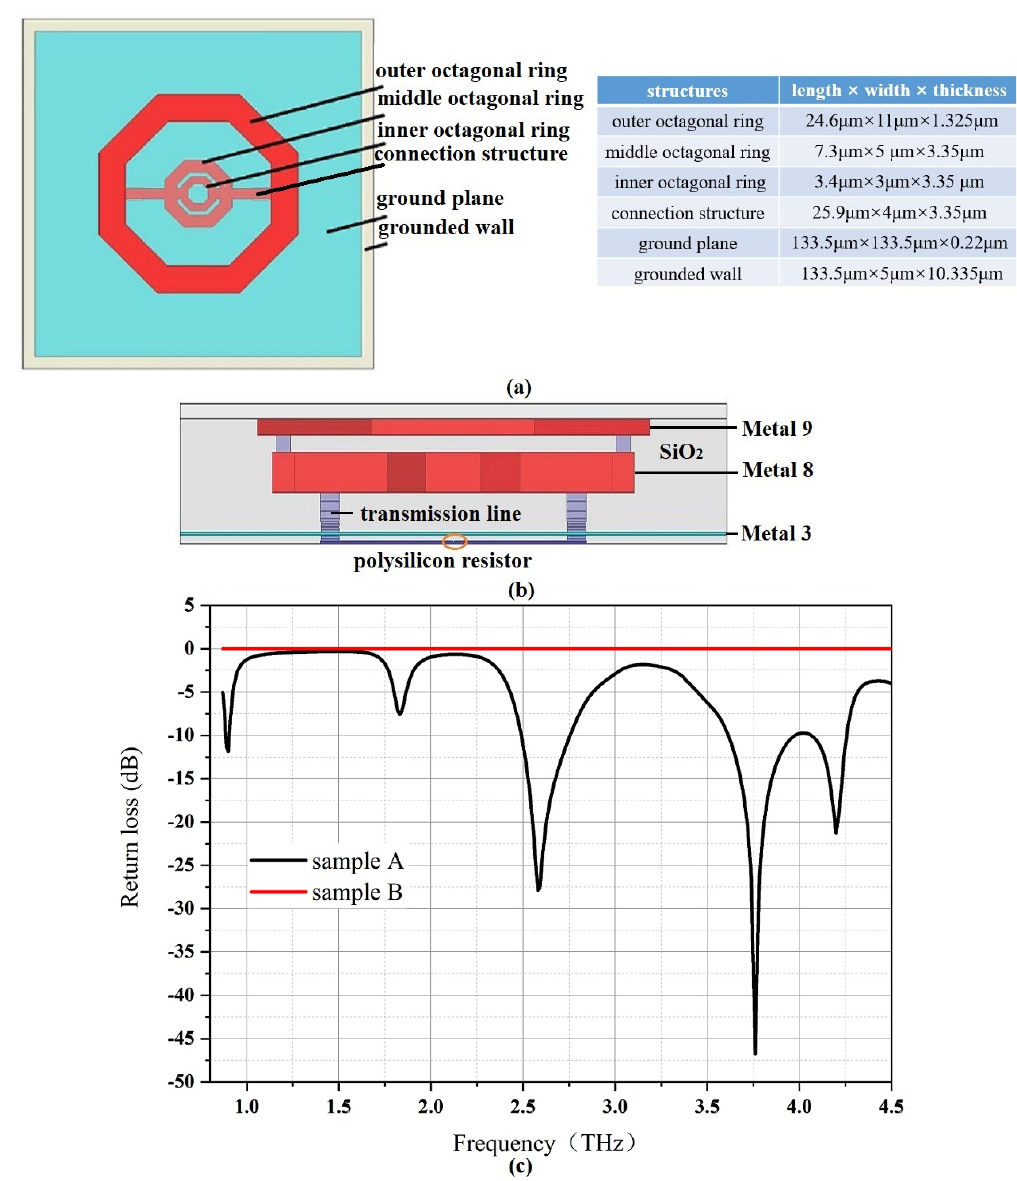
Figure 2. Designed antenna: ( a ) top view; ( b ) side view; ( c ) simulated return loss.